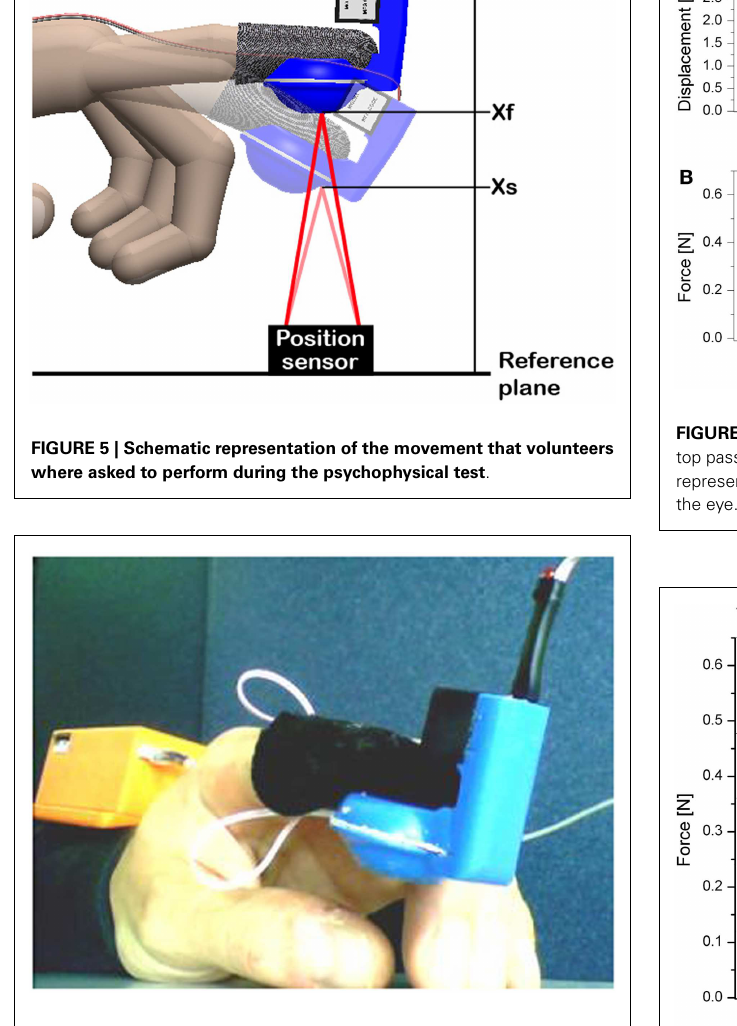
FIGURE 6 | Picture of the prototype fingertip display . A box containing the wireless controller is visible in the rear part, arranged on the user’s forearm.